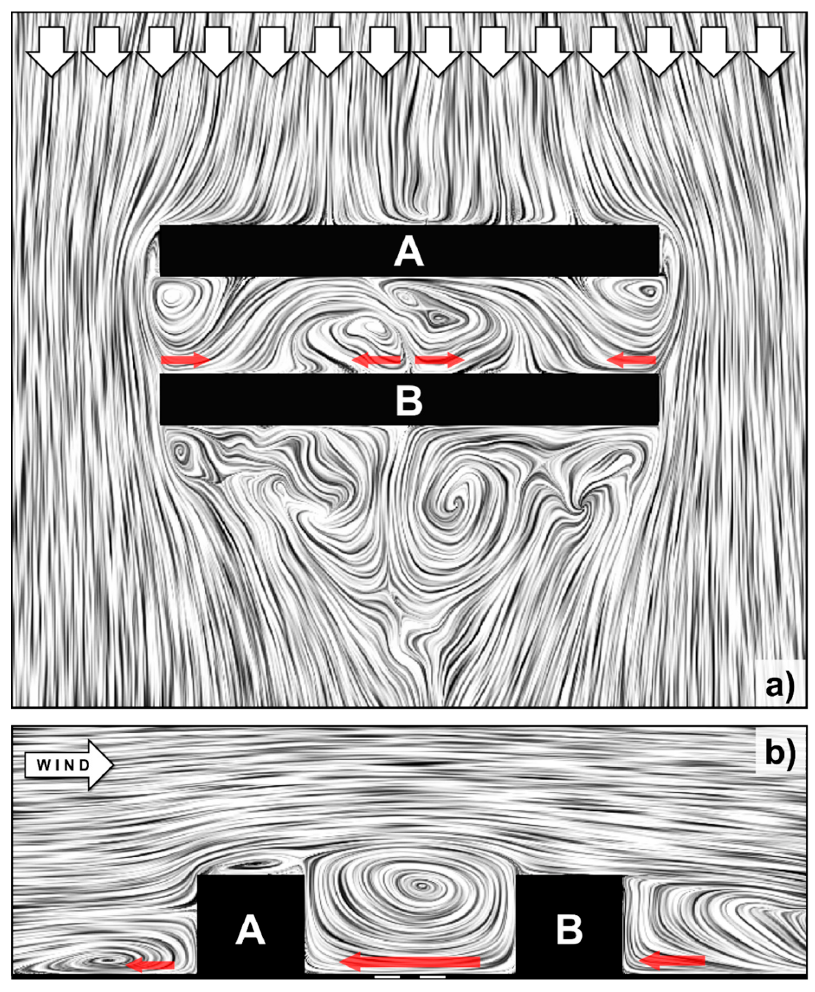
Figure 8. Time-averaged streamlines around the buildings ( a ) from top view, at z /H = 0.5; and ( b ) from side view, at y /H = 4. side view, at y /H =